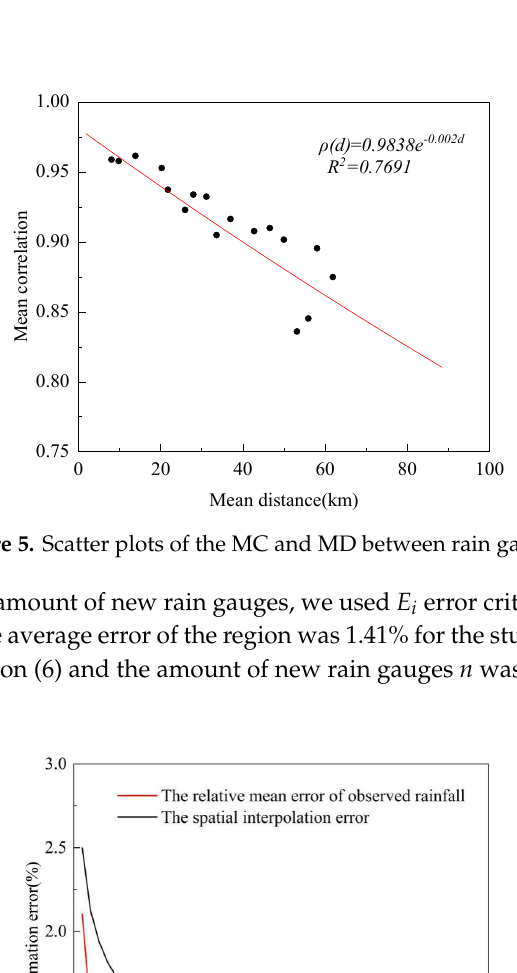
Figure 6. Number of rain gauges against estimation errors for the Jinjiang Basin.